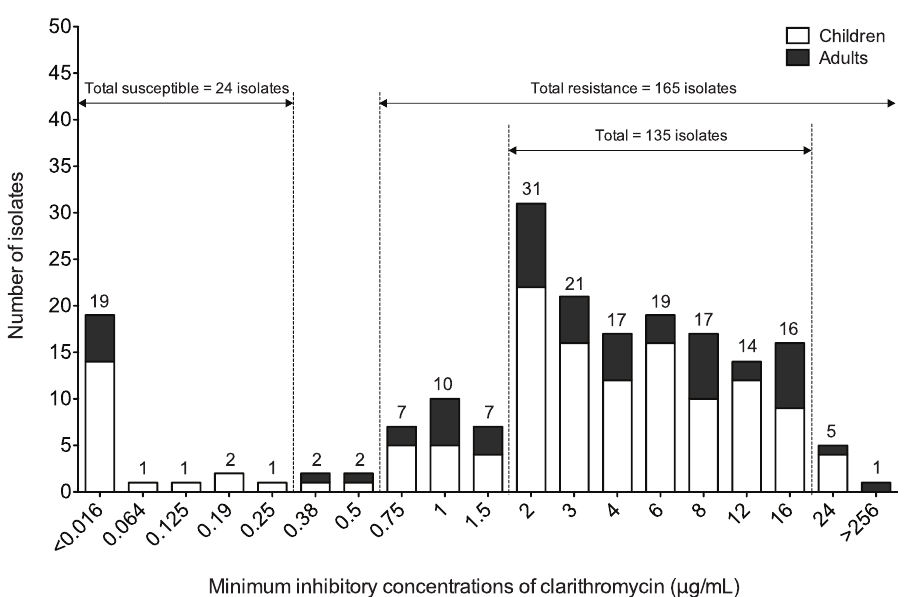
Figure 2. Minimum inhibitory concentration values of clarithromycin susceptible and resistant isolates in children and adults. The graph shows the number of isolates across a range of minimum inhibitory concentration values of clarithromycin. The total number of clarithromycin susceptible and resistant isolates is 24 and 165, respectively. Majority of clinical isolates resistant to clarithromycin have MIC values ranging from 2 μg/mL to 16 μg/mL.